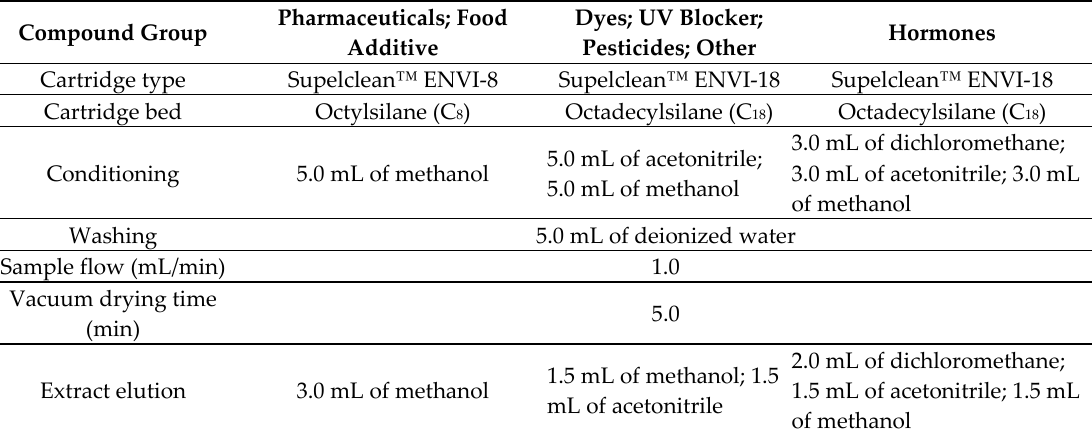
Table 2. Solid Phase Extraction details for different compound